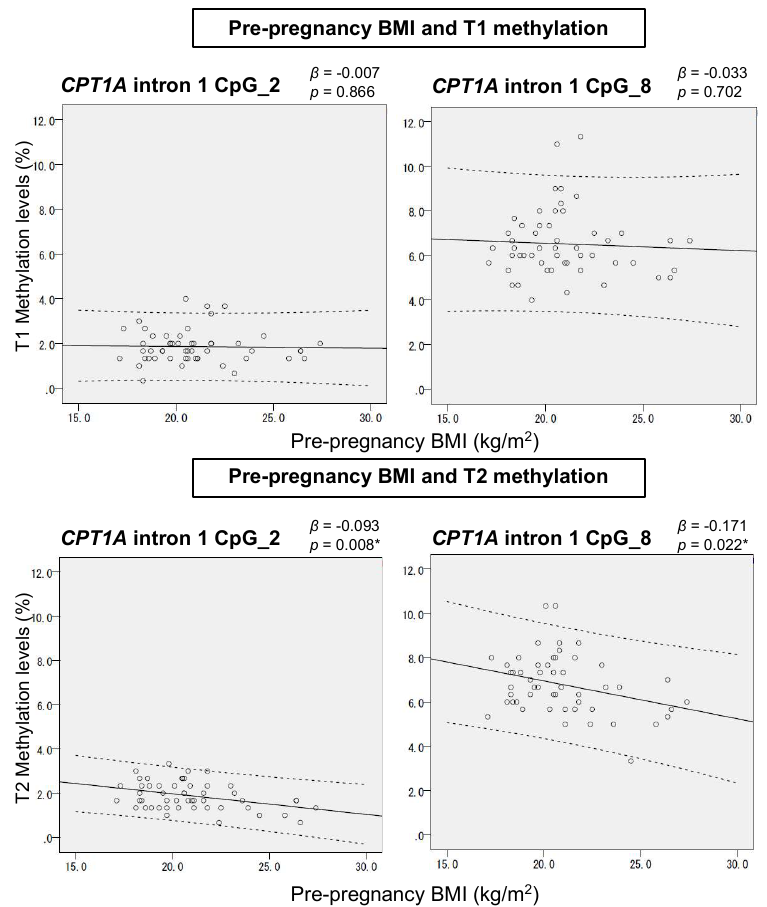
Figure 6. Scatter plots showing the relationship between pre-pregnancy BMI and CPT1A intron1 methylation. Solid line, a regression line; dotted line, 95% confidence intervals. The scale is adjusted to the methylation for each CpG site. β (regression coefficient) stands for the % change in methylation per unit increase (1 kg/m 2 ) in